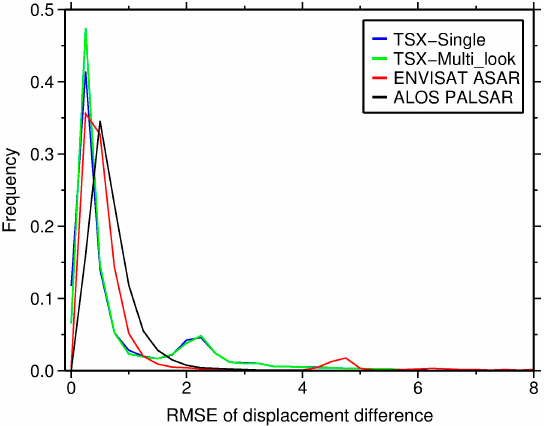
Figure 12. Histograms of deformation time-series RMSE difference caused by external DEM difference and geocoding multi-look operations for the three platforms. The blue line represents the histogram of deformation time-series RMSE difference between single-look geocoding with TanDEM-X DEM and single-look geocoding with SRTM-1arc DEM. The green line represents the result between single-look geocoding with TanDEM-X DEM and multi-look geocoding with SRTM-1arc DEM. Red and black lines represent the results of ENVISAT ASAR and ALOS/PALSAR images with single-look geocoding operation respectively.